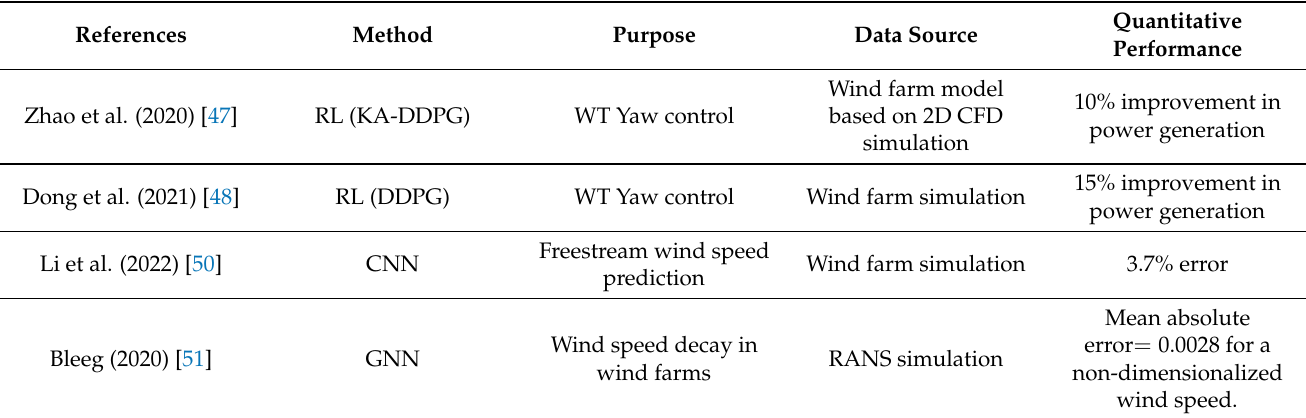
Table 2. NN-based wind farm control and modeling